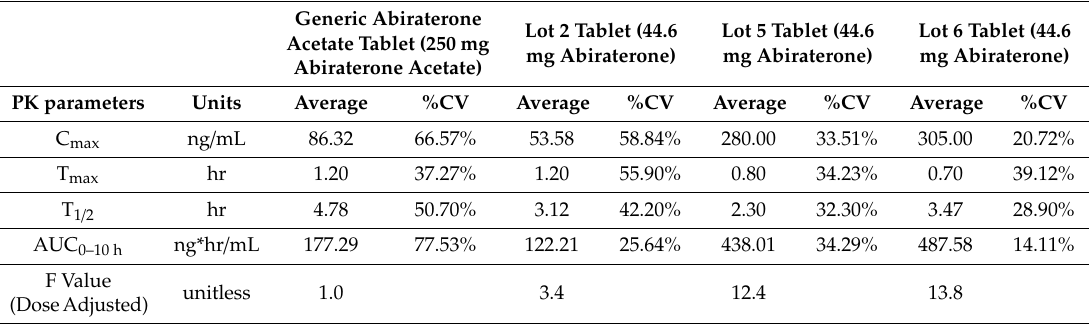
Table 5. Results from the in vivo pharmacokinetic (PK) study in male beagle dogs.